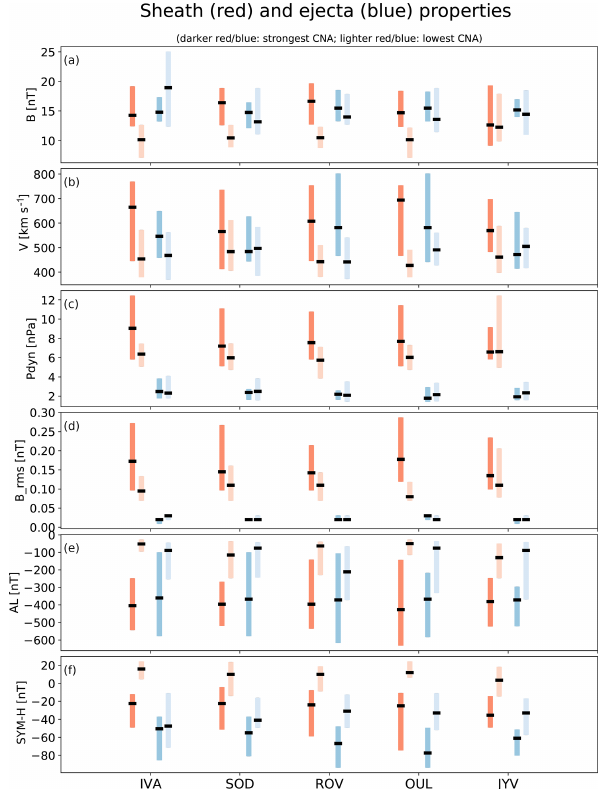
Figure 9. The medians (thick black horizontal bars) and interquar- tile range (IQR; coloured boxes) of (left) sheath and (right) ejecta properties and associated geomagnetic responses. The darker-red and blue boxes show the IQRs for events associated with strongest CNA, and lighter-red and blue boxes show the events associ- ated with weakest CNA. The panels give the (a) interplanetary- magnetic-field magnitude, (b) solar-wind speed, (c) dynamic pres- sure, (d) magnetic-field fluctuations estimated from root mean square, and (e) AL and (f) SYM-H